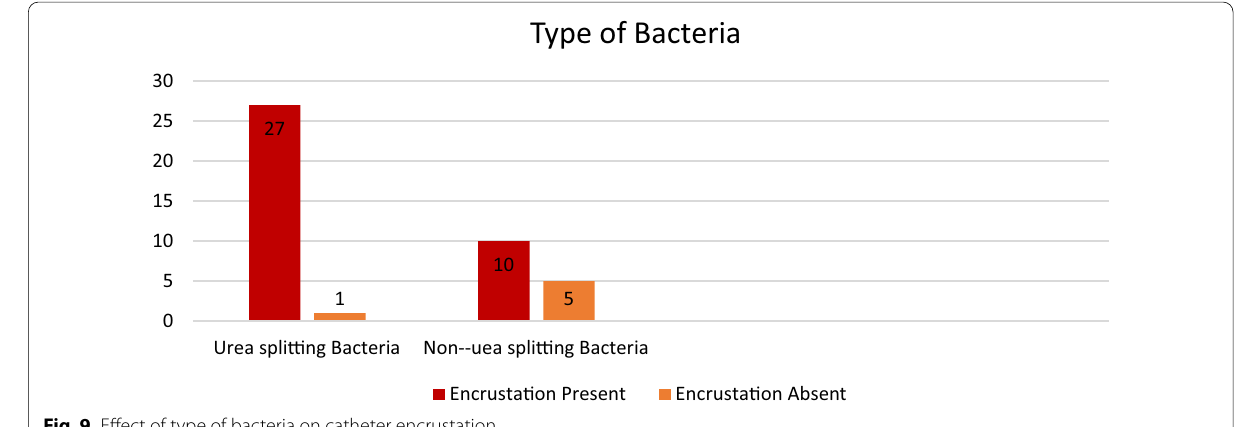
Fig. 9 Effect of type of bacteria on catheter